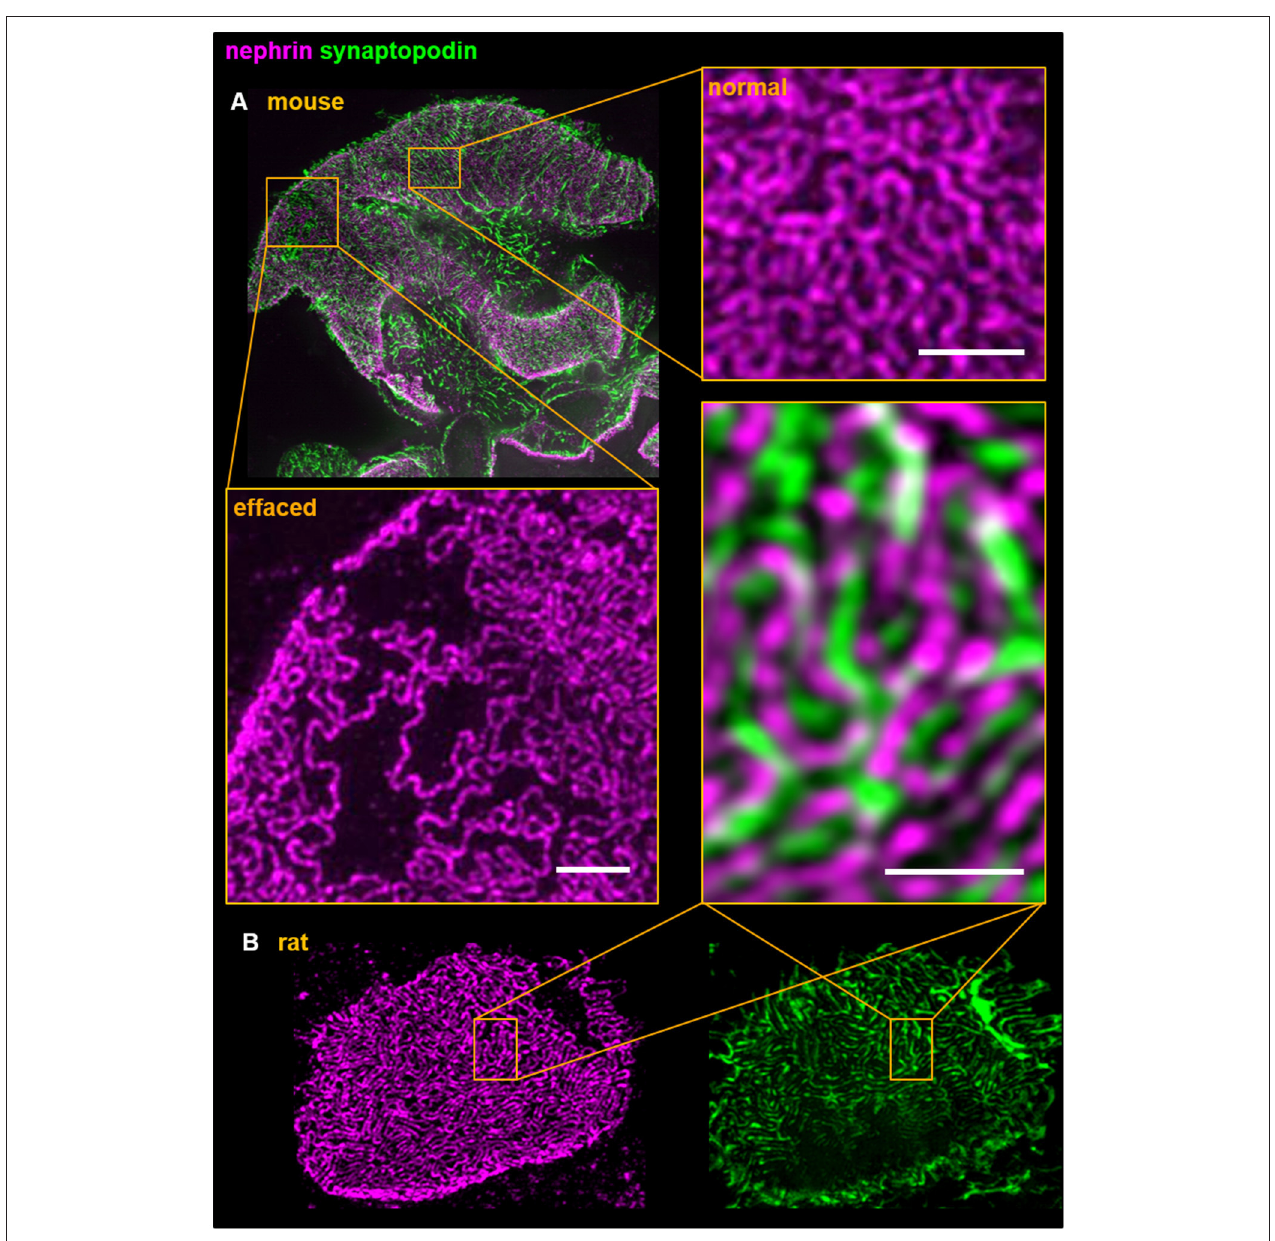
FIGURE 3 | Dual color 3D-SIM of rodent (A) in mouse and (B) in rat) paraffin kidney sections shows the interdigitating foot process pattern of podocytes. Foot processes and the slit diaphragm were labeled using anti-synaptopodin and anti-nephrin antibodies, respectively. Although both proteins are in close structural vicinity the individual staining patterns do not overlap and therefore demonstrates the high resolution accomplished by 3D-SIM. All scale bars represent 1 µ